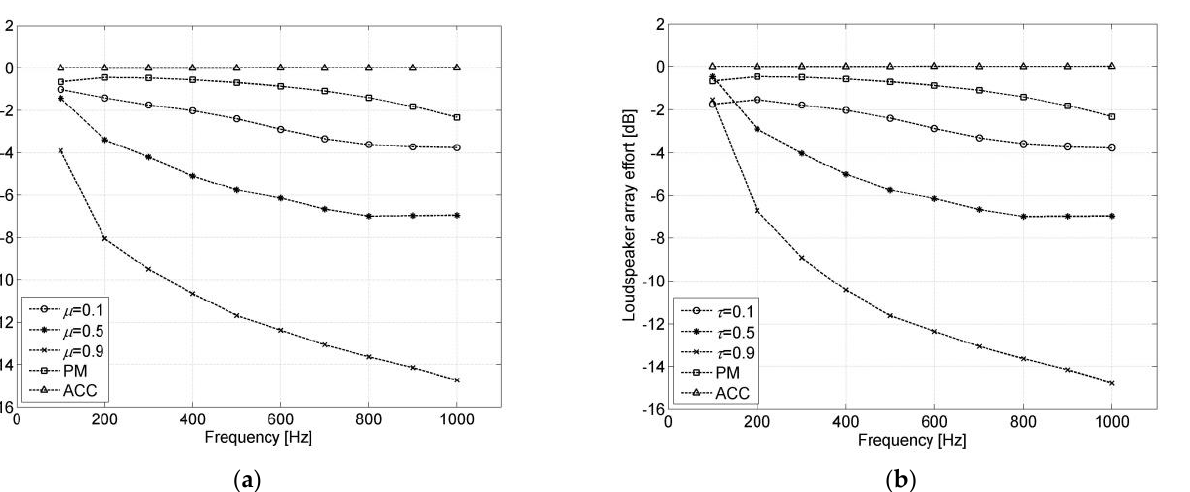
Figure 6. Array effort of different methods for two-dimensional experiment. ( a ): PM method in bright zone, ACC method, the first proposed method with µ = 0.1, 0.5 and 0.9; ( b ): PM method in bright zone, ACC method, the second proposed method with = 0.1, 0.5 and 0.9.